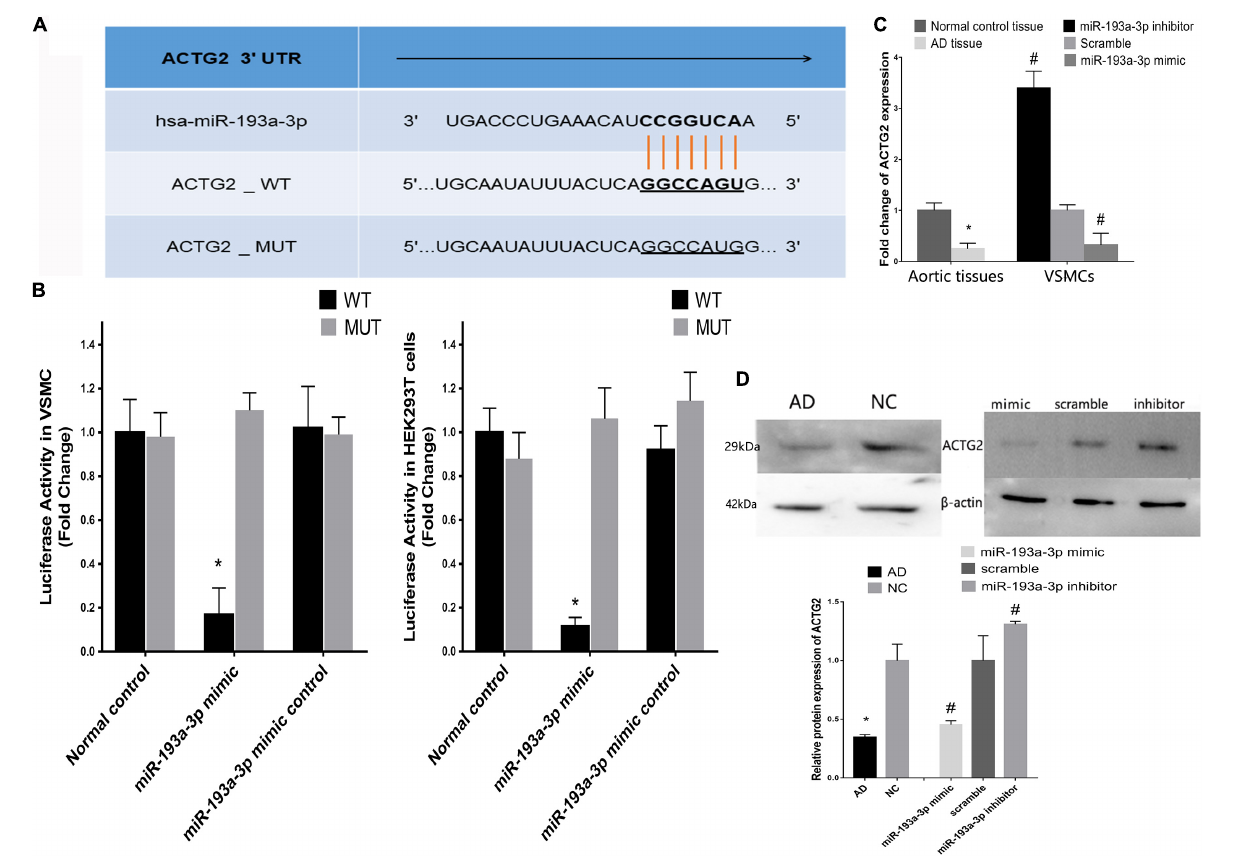
FIGURE 8 | Correlation between miR-193a-3p and ACTG2 in AD. (A) miR-193a-3p targets the 3 (cid:48) untranslated region of ACTG2. (B) Dual luciferase assay showing the effect of miR-193a-3p on the wildtype and mutant 3 (cid:48) untranslated region of ACTG2 in HEK293T cells ( n = 6, * P < 0.05). (C) Reduction in the mRNA levels of ACTG2 in tissues from patients with AD and VSMCs transfected with the miR-193a-3p mimic (* P < 0.05, # P < 0.05). (D) Western blots showing the decrease in the protein levels of ACTG2 in tissues from patients with AD and miR-193a-3p mimic-transfected VSMCs (* P < 0.05, # P <